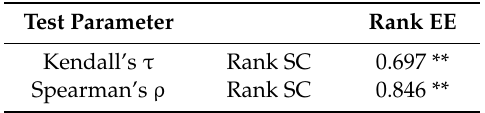
Table 16. Consistency test II (inter-groups: SC and EE panels).